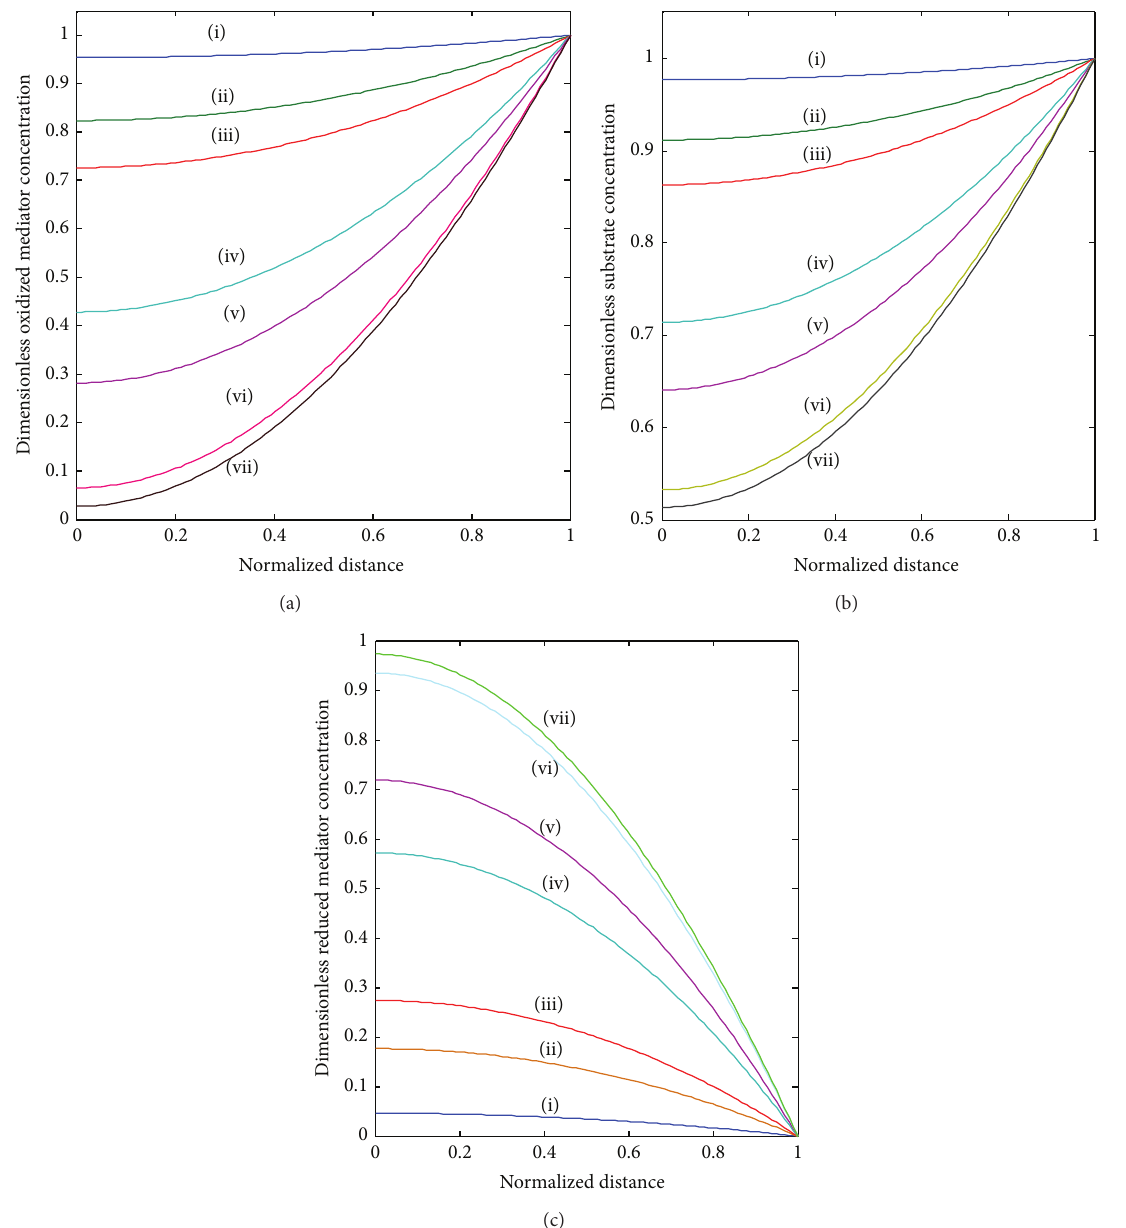
Figure 4: Dimensionless concentration of (a) oxidized mediator 𝐹 values of parameters 𝐵 = 0.005 . (iii) 𝐵 (ii) 𝐵 S